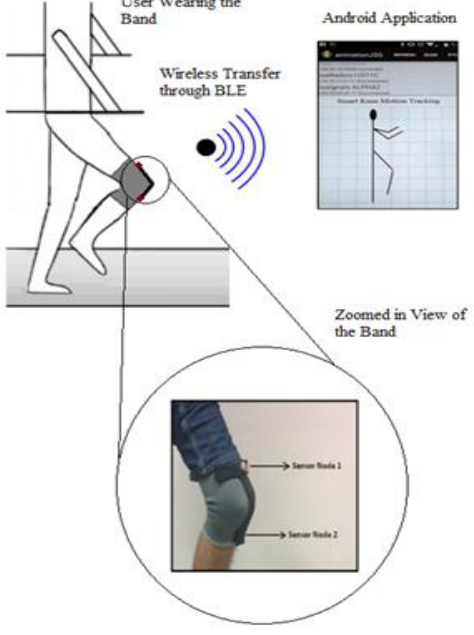
Figure 1 Wearable System